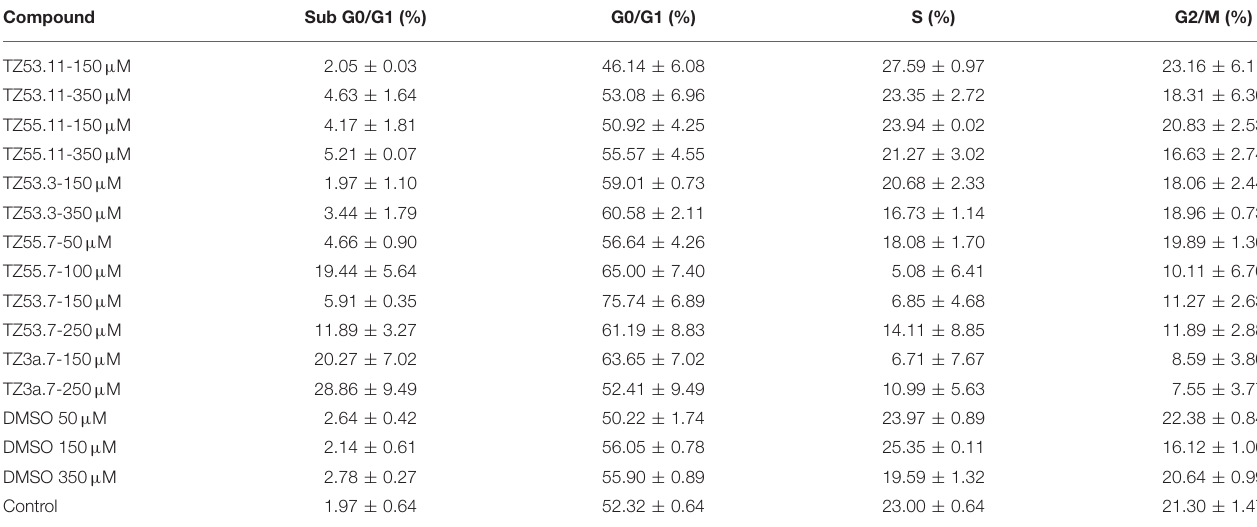
TABLE 4 | Viability of HT-29 human colorectal adenocarcinoma cell line induced by the tested compounds in the four cell cycle phases; average values ± standard deviation of three separate experiments.